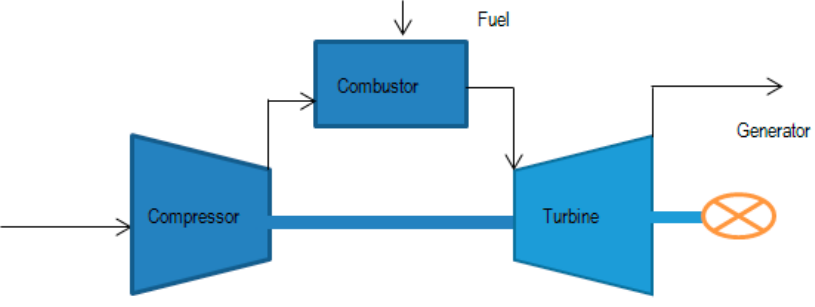
Figure 1. Main sections of a gas turbine.